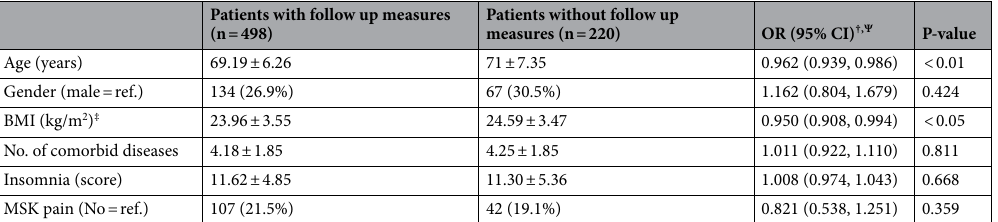
Table 6. Sensitivity analysis of patients with or without follow up measures^ (Mean ± standard deviation (SD)/ count (col %)). ^ Abbreviations: BMI: Body Mass Index; MSK: Musculoskeletal; OR: Odds ratio; CI: Confidence interval; † Patients with or without follow up measures was categorized 1 or 0 (reference); Ψ Multiple logistic regression; ‡ There is a missing data because one participant is a wheelchair user and his body weight cannot be